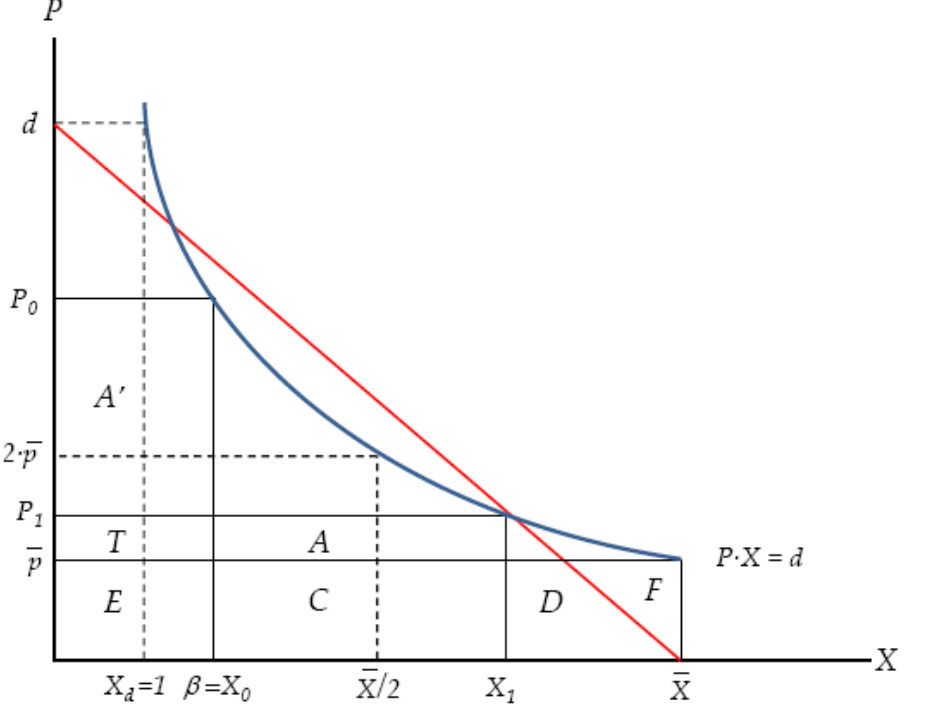
Figure 2: A suitable framework for the vaccines domestic